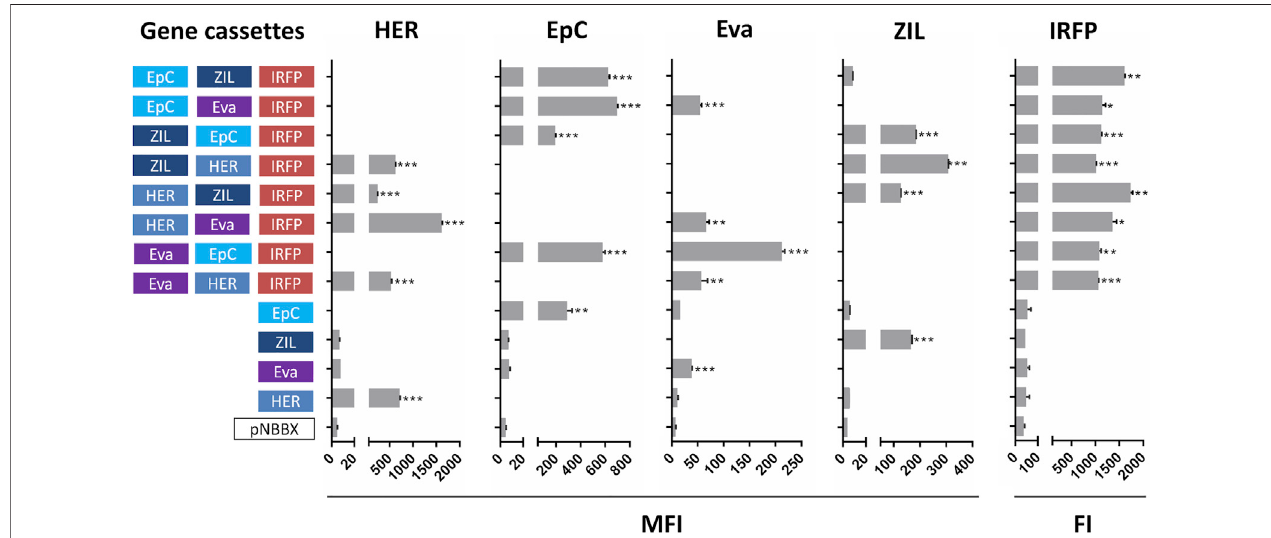
FIGURE 3 | Surface display of individual protein binders (cassettes HER, EpC, Eva and ZIL) assessed by fl ow cytometry (mean fl uorescence intensity, MFI), and expression of fl uorescent protein IRFP (cassette IRFP) assessed by measuring fl uorescence ( fl uorescence intensity, FI) in L. lactis containing pNBBX with up to three gene cassettes (denoted in 5 ′ -3 ′ direction). * p < 0.01, ** p < 0.001, *** p <